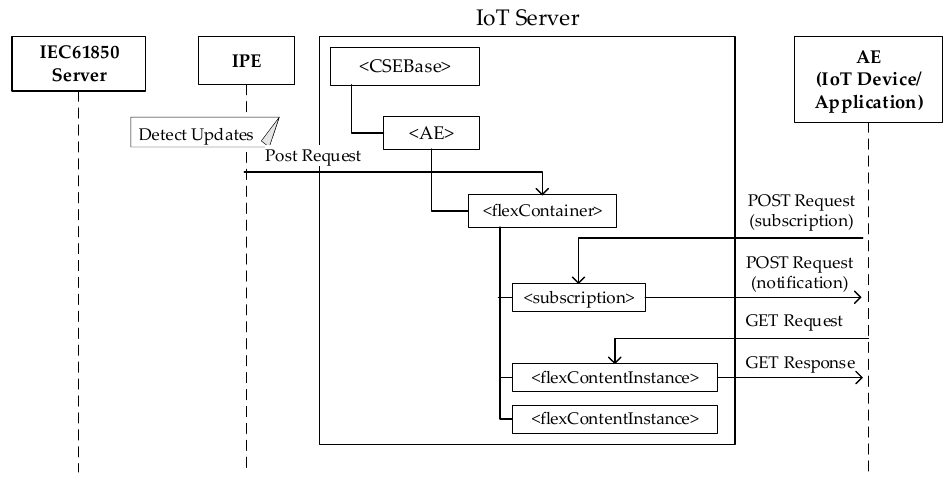
Figure 17. Retrieving information produced by IEC 61850 Server.